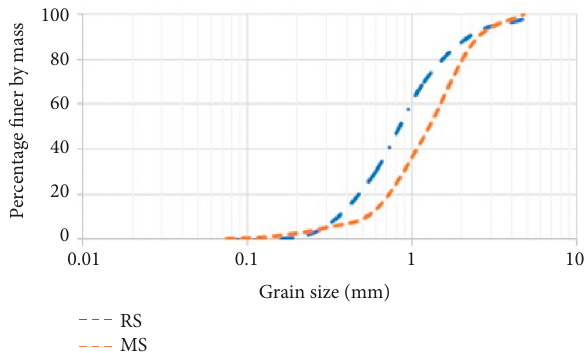
Figure 2: Particle size distribution of river sand and M-sand.